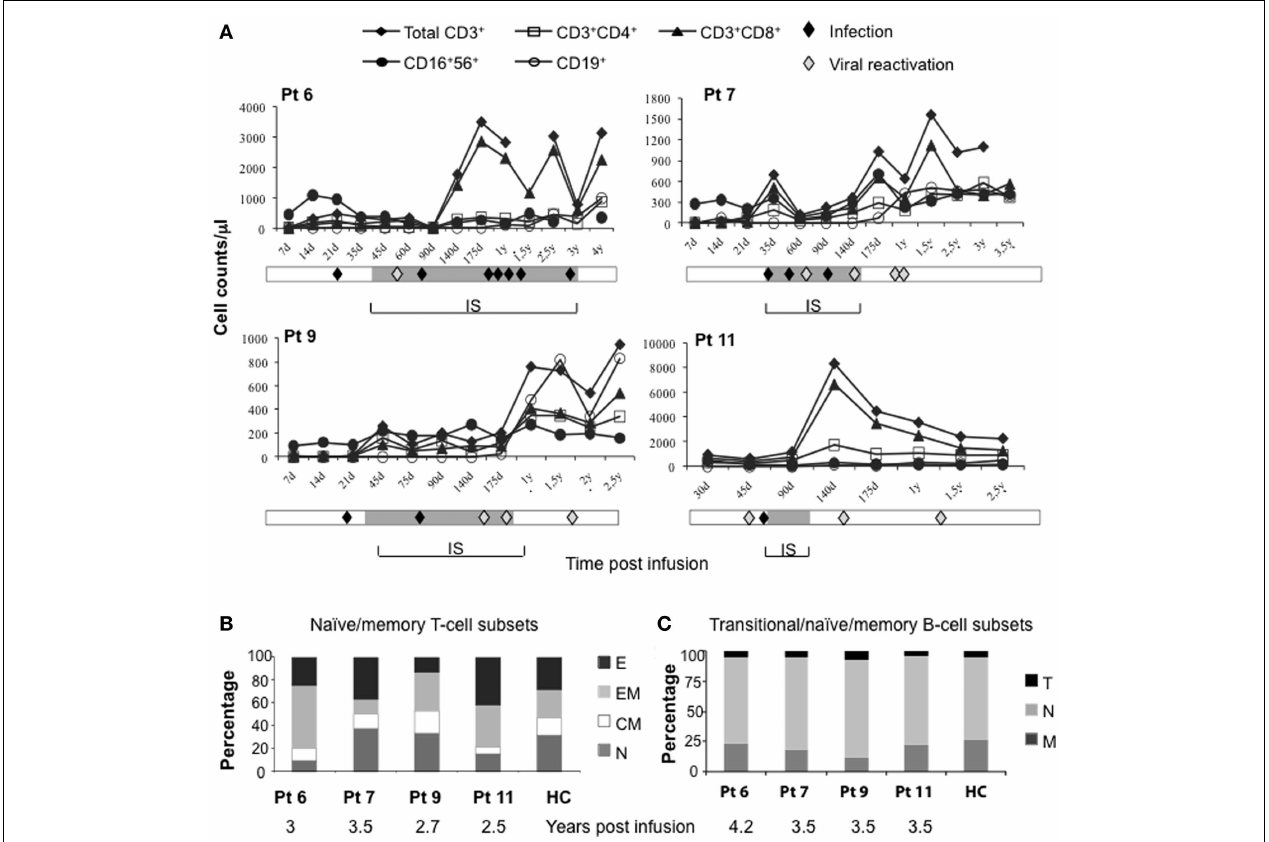
virus, Herpes-Simplex virus, Hepatitis B virus) reactivations detected by molecular analysis prior to the appearance of clinical manifestations are indicated (filled and empty diamonds, respectively). (B) Relative distribution of naïve and memory in gated CD3 + T cells. E, effectorT cells (CD62L − CD45RA + ); EM, effector-memoryT cells (CD62L − CD45RA − ); CM, central memoryT cells (CD62L + CD45RA − ); N, naïve (CD62L + CD45RA + )T cells. HC, n = 20. (C) Relative distribution of B-cell subsets, according to the expression of CD24 and CD38 in gated CD19 + B-cells.T, transitional B cells (CD24brightCD38bright); N, naïve/mature